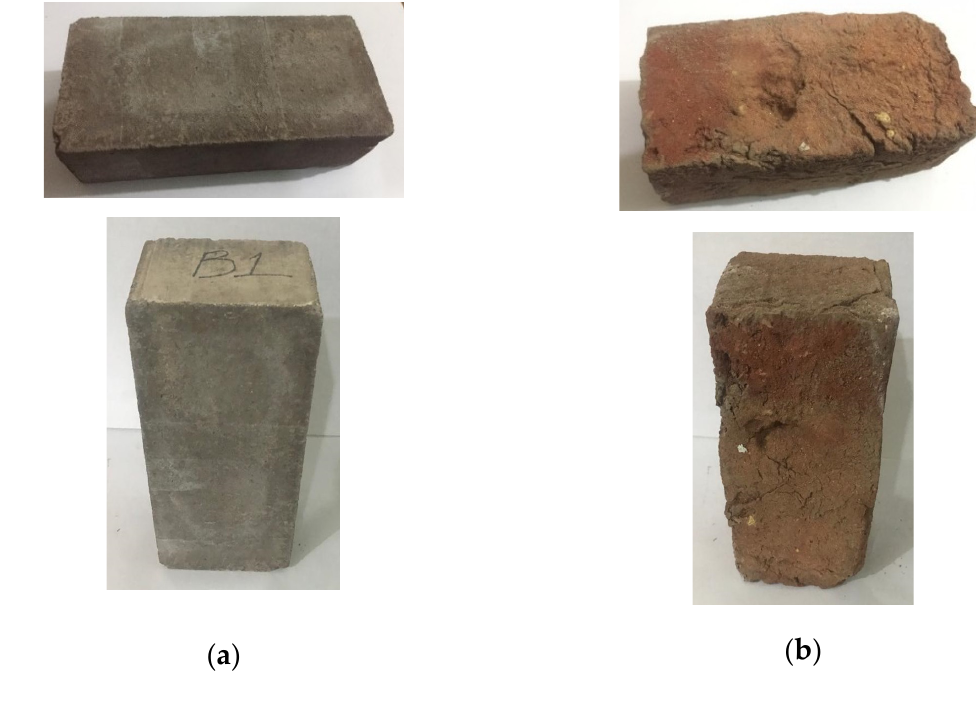
Figure 15. Efflorescence of the brick samples.